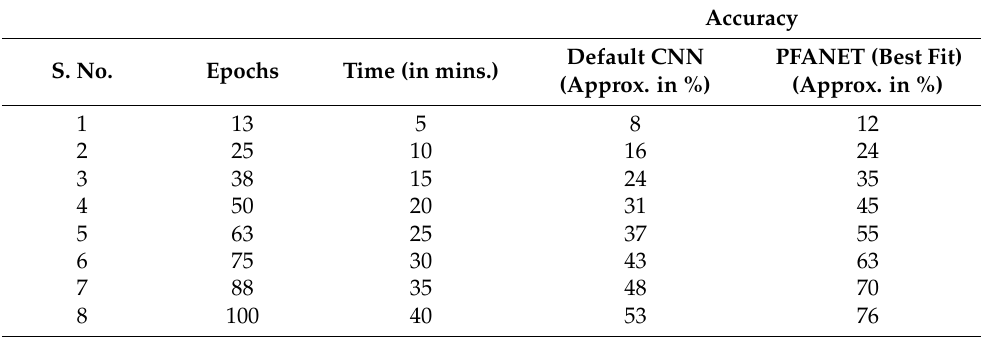
Table 1. Accuracies in a default CNN and the network evolved with PFA are compared over best fits, shown as the steps of time and epochs elapsed.